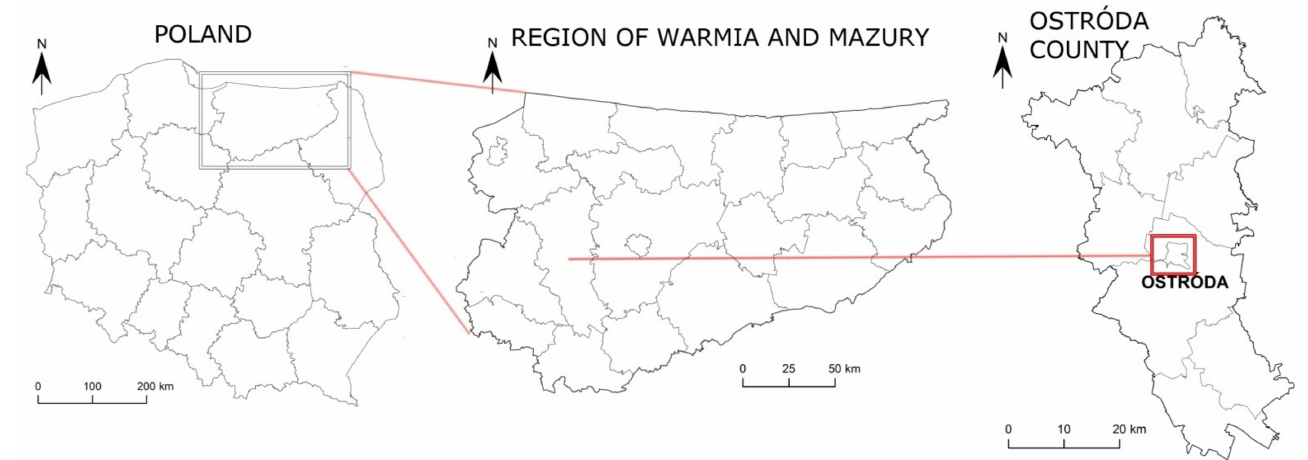
Figure 1. Location of the town of Ostr ó da in Poland, the Region of Warmia and Mazury and Ostr ó da